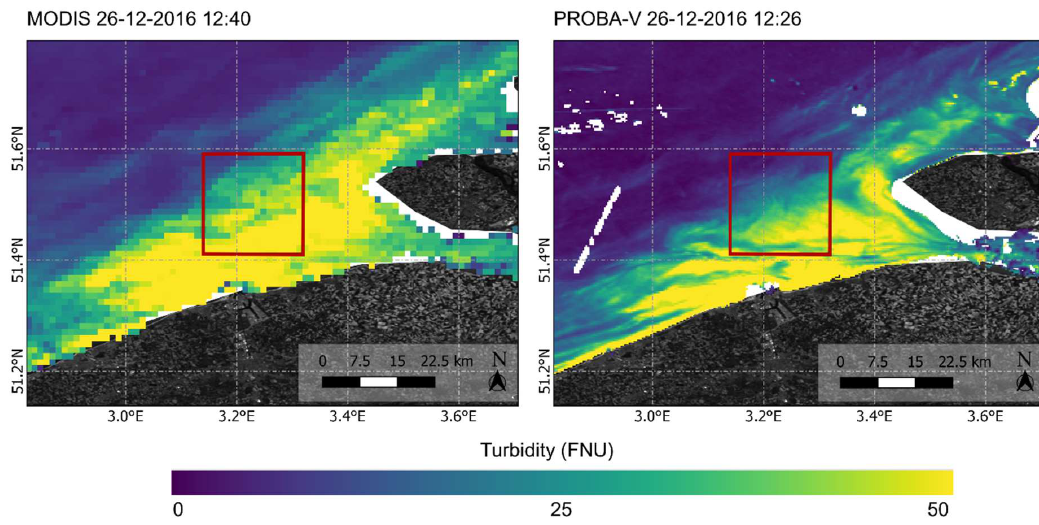
Figure 10. Turbidity map of the Scheldt outlet region generated with MODIS ( left ) and PROBA-V ( right ) data for the acquisition on 26/12/2016.